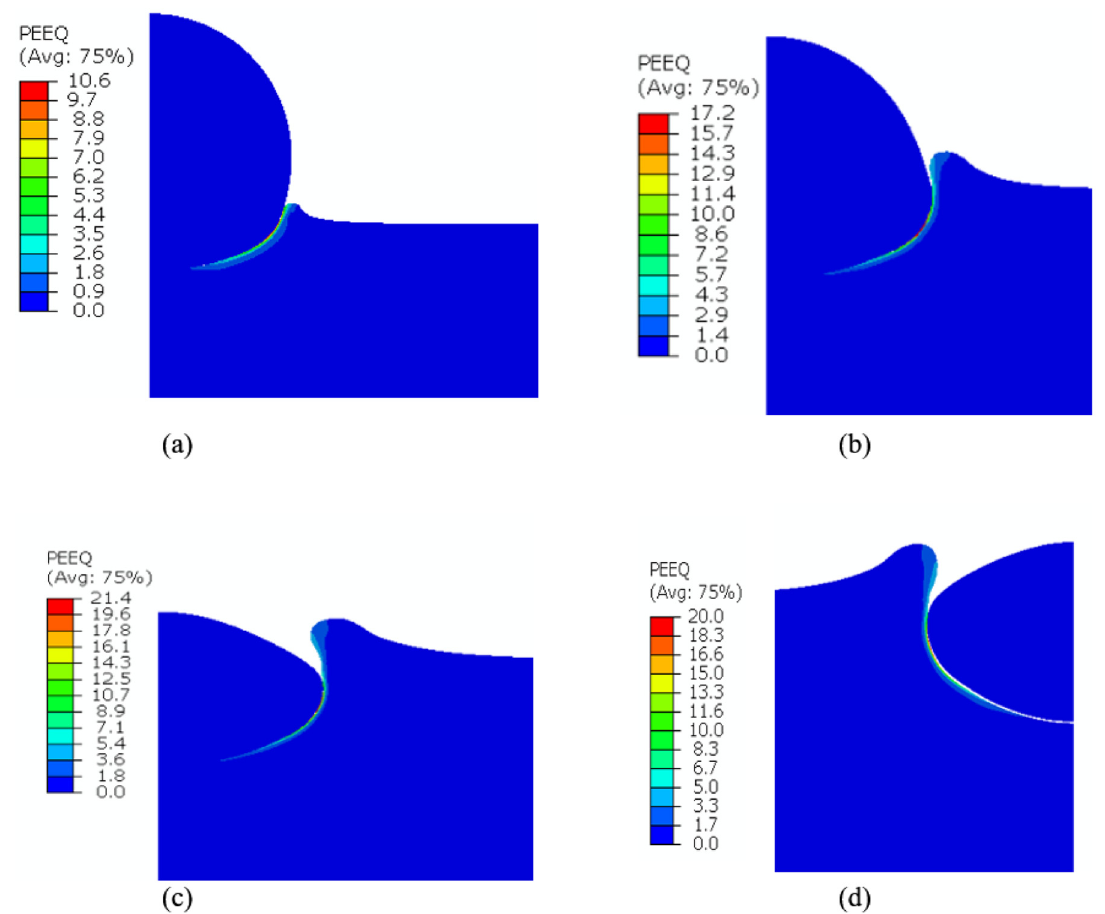
Fig. 7. Equivalent plastic strain evolution (PEEQ) at 500m/s Cu/Al impact at different impacting times of (a) 5ns (b) 10ns (c) 20 ns (d) 30 ns by using the ALE numerical